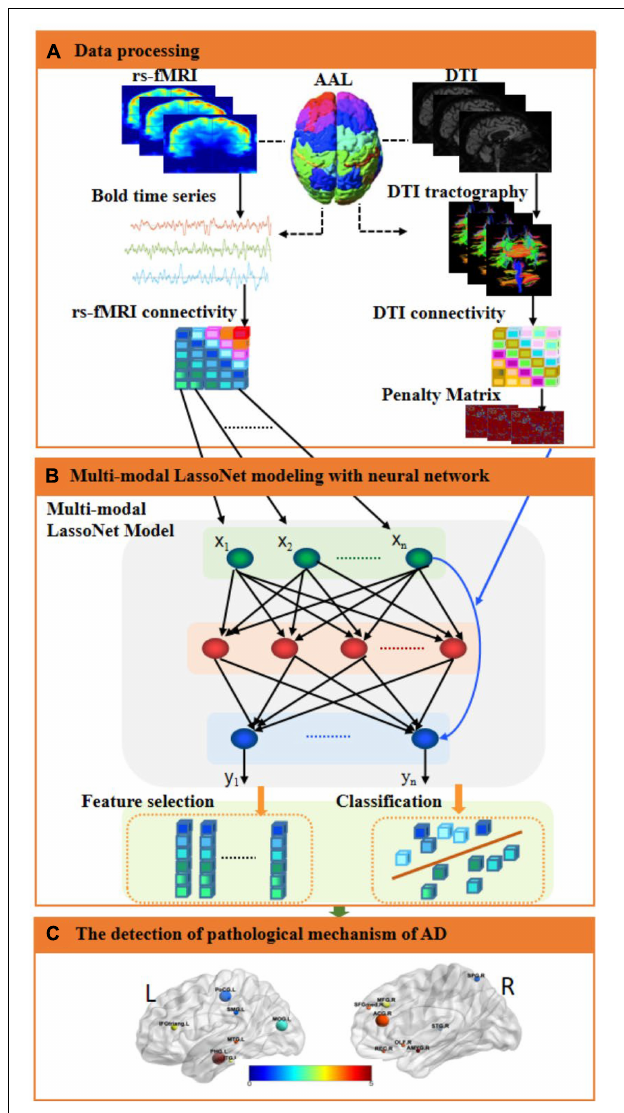
FIGURE 1 | An illustration of the proposed multi-modal framework for AD. (A) Data processing. The fMRI and DTI images were preprocessed, and then the regions of interest were extracted as fMRI and DTI features through the AAL template, and the corresponding brain networks of fMRI and DTI were obtained, respectively. Then, computed the inverse proportional function of the structural brain network as a penalty matrix. (B) Multi-modal LassoNet Modeling with a neural network. We constructed a multi-modal network framework for feature selection and classification based on the LassoNet model. It consisted of residual connection and an arbitrary feed-forward neural network. The input to the network was the fMRI feature information. The penalty matrix was introduced to the residual connection to sparse features. (C) The detection of the pathological mechanism of AD. We visualized brain regions for selected features to analyze the affected discriminative brain regions.